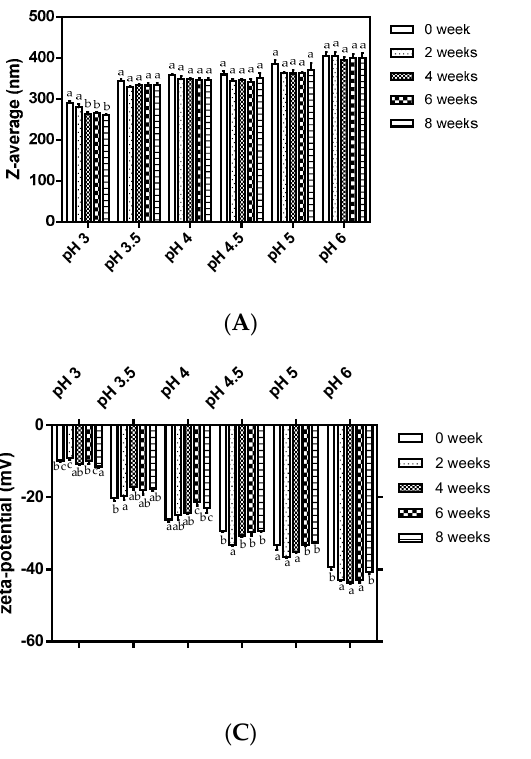
Figure 3. Z-average ( A ), polydispersity index (PDI) ( B ) and ζ -potential ( C ) changes of zein-caseinate- Figure 3. Z ‐ average ( A ), polydispersity index (PDI) ( B ) and ζ‐ potential ( C ) changes of pectin particles during storage at 4 ◦ C. zein ‐ caseinate ‐ pectin particles during storage at 4 °C.